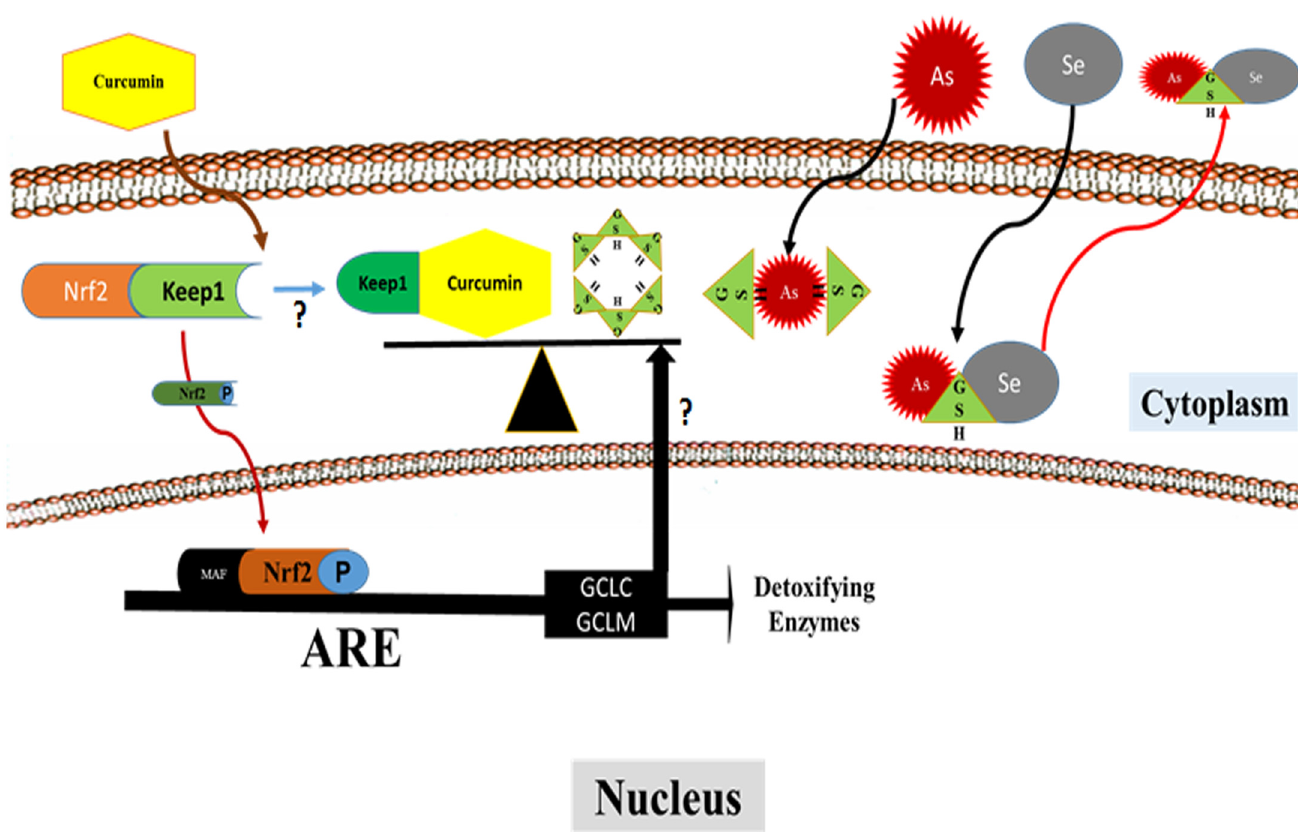
Fig 6. Pathway diagram showing Nrf2 activation and enhanced GSH biosynthesis through curcumin and release of arsenic via selenium and GSH complex.